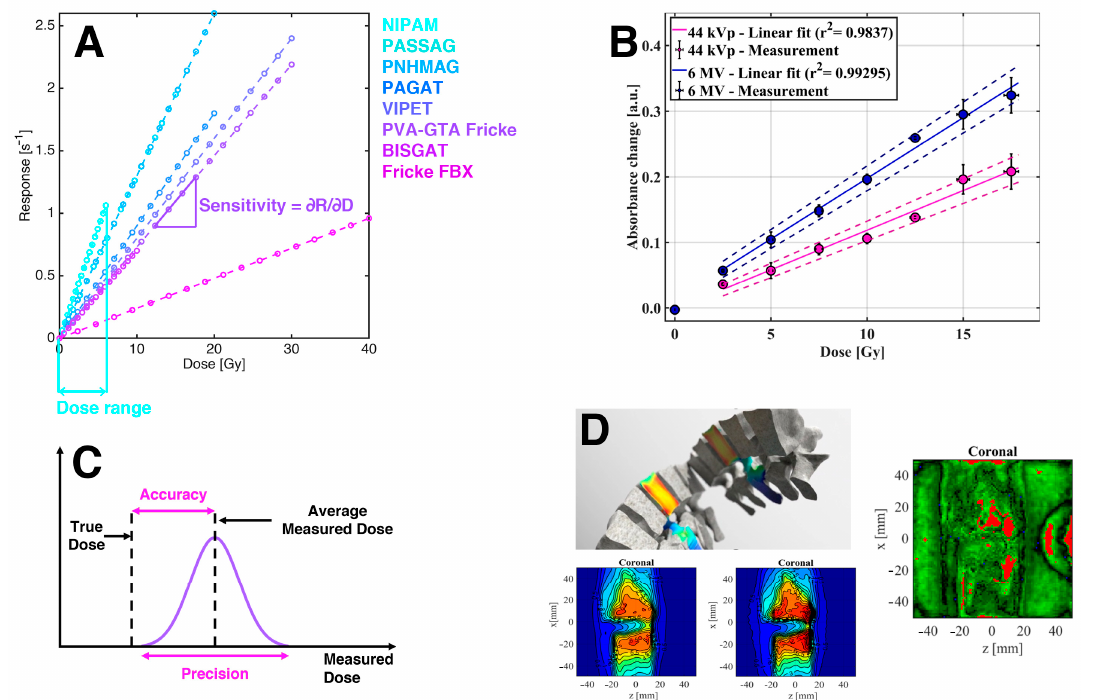
Figure 4. Relevant dosimetry parameters. ( A ) Qualitative sensitivity and dose range values for different gel dosimetry systems. ( B ) Comparison of the response behavior at two very different energy values for Fricke gel. ( C ) Graphical representation of the accuracy and precision of dosimetry measurements. ( D ) Typical quality assurance analysis with gel dosimetry. Example of an irradiation of a vertebra ( upper left ), dose map for a coronal slice obtained with TPS ( lower left ), dose map for a coronal slice obtained with a PGD ( lower center ), and 2D gamma pass map between the TPS and PGD dose maps ( right